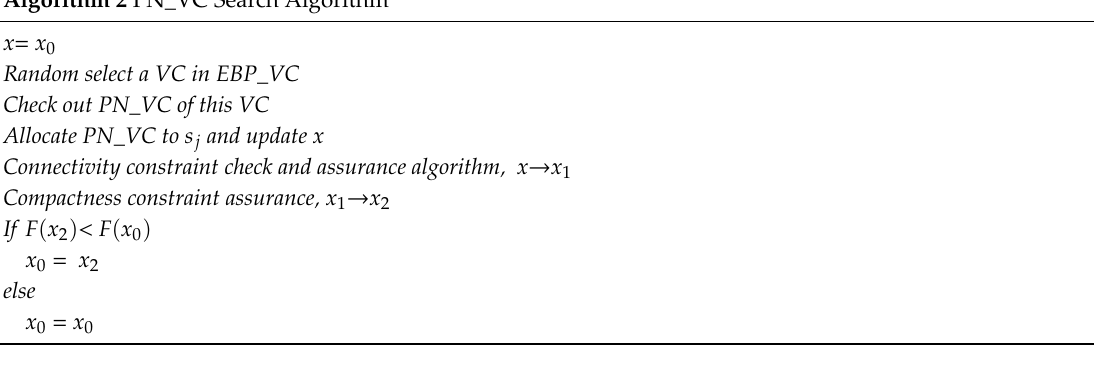
Algorithm 2 PN_VC Search Algorithm